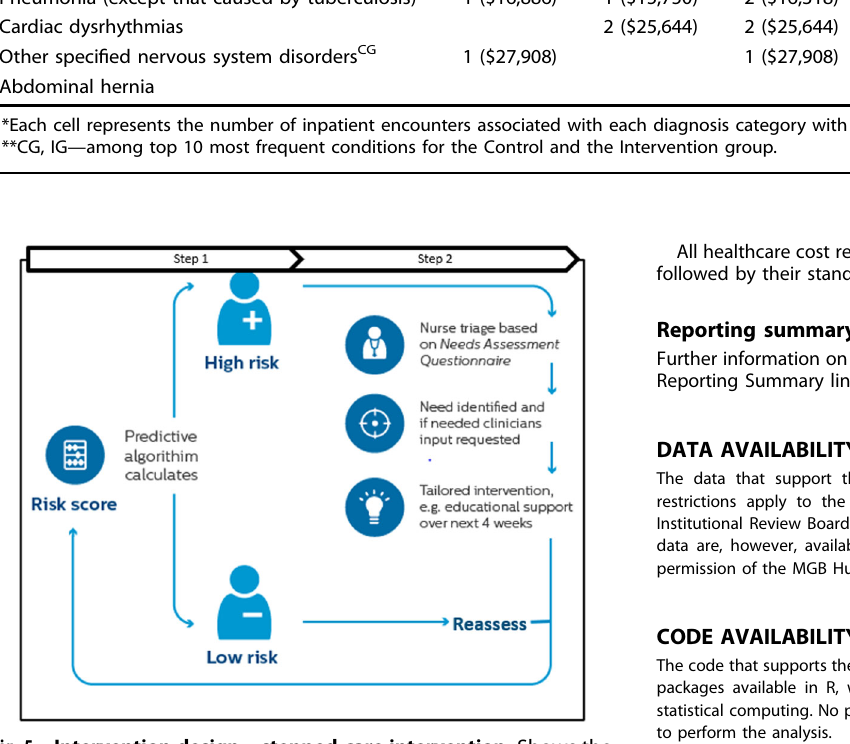
Fig. 5 Intervention design — stepped-care intervention. Shows the (step one) predictive model output as risk scores, followed by (step two) nurse triage for patients fl agged as high risk. The fi gure also demonstrates how patients are regularly reassessed by the